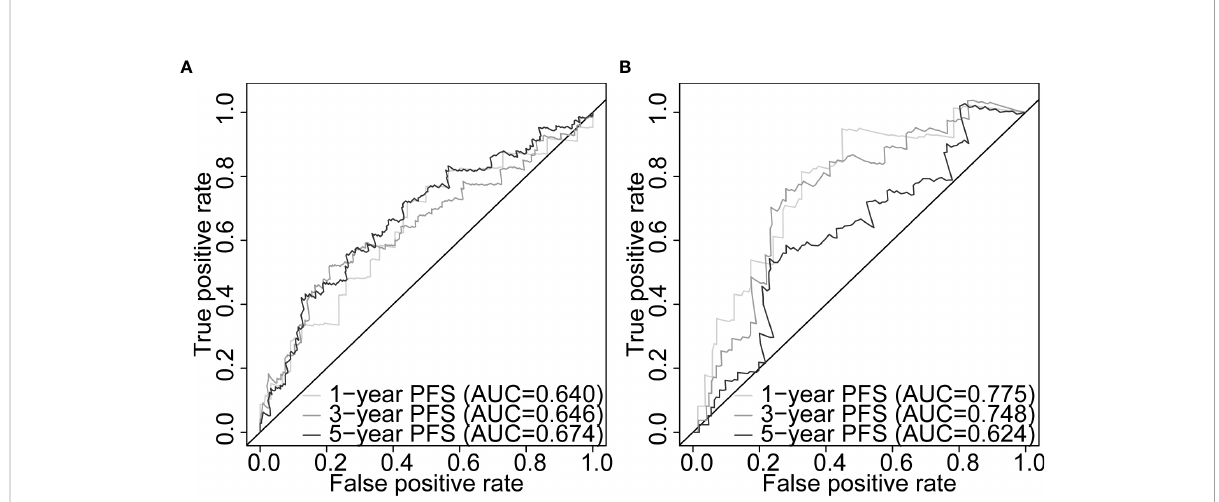
FIGURE 5 Five-gene signature evaluation of PFS in PCa patients. Time-dependent ROC curves assessing the fi ve-gene signature performance for 1-, 3-, and 5-year PFS in TCGA-PRAD training set (A) and TCGA-PRAD testing set (B) . PCa, prostate cancer; PFS, progression-free survival; TCGA, The Cancer Genome Atlas; PRAD, prostate adenocarcinoma; ROC, receiver operating